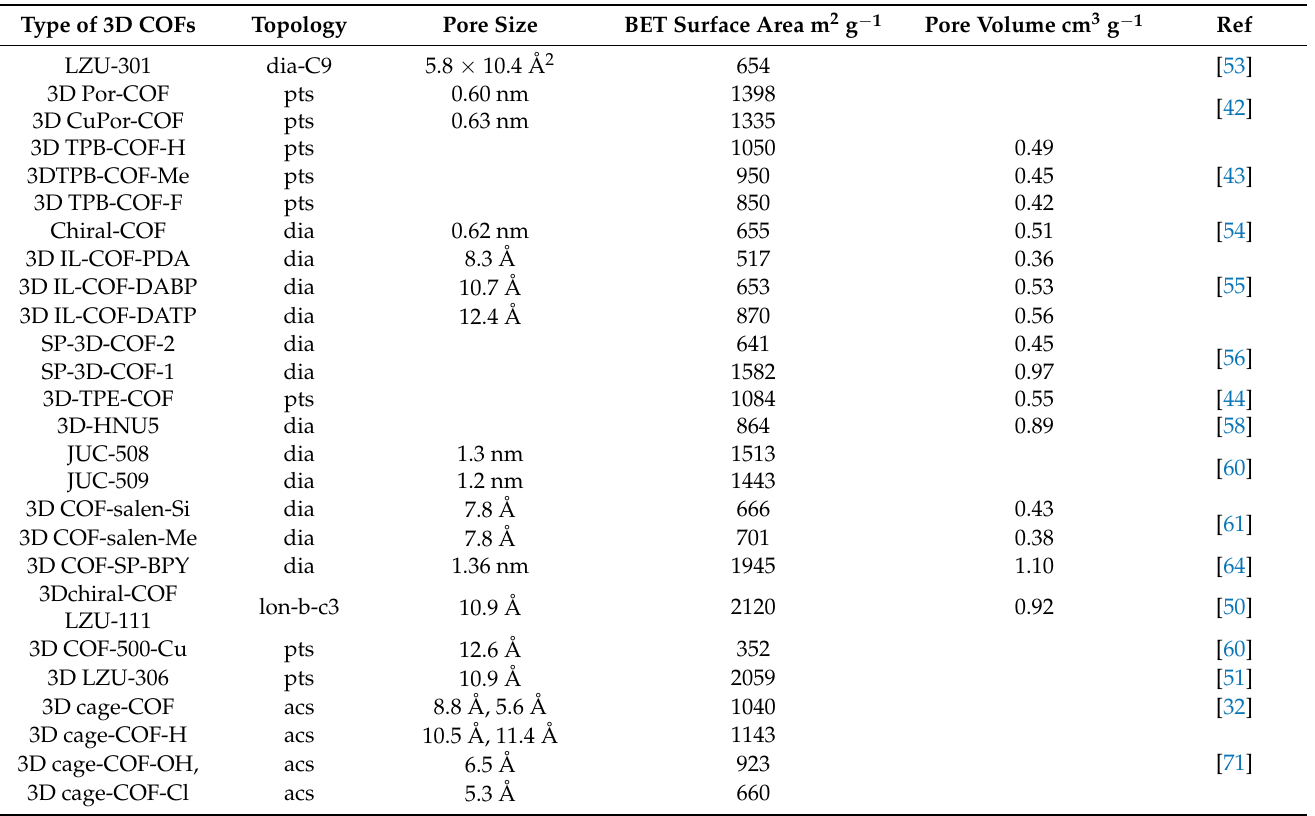
Table 1. The comparative properties of 3D